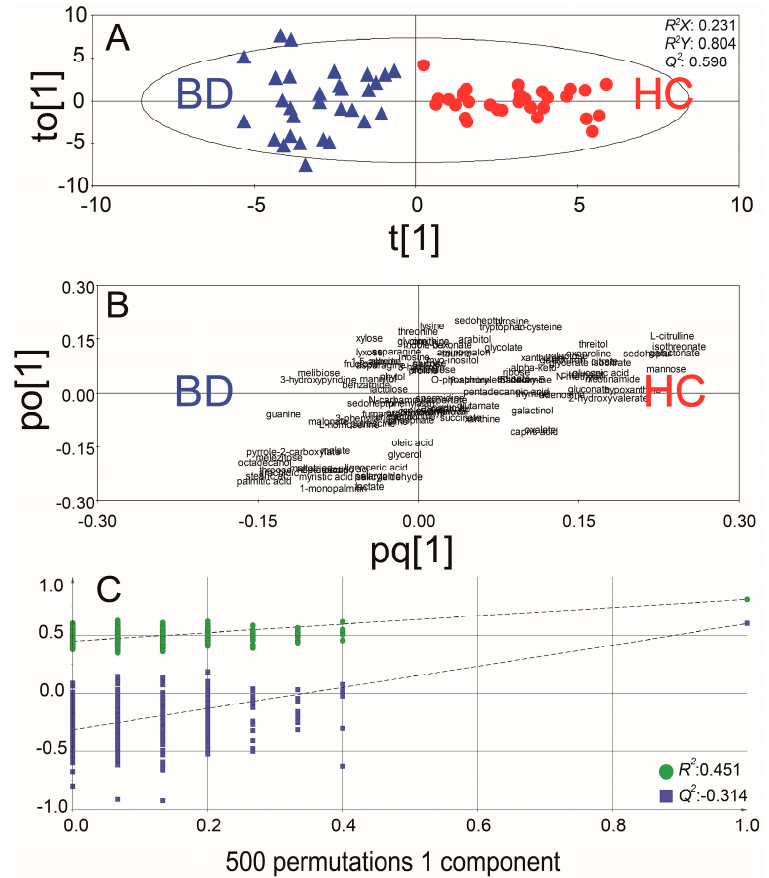
Figure 1. The score plot ( A ), and the loading plot ( B ) of the orthogonal partial least squared-discrimination analysis (OPLS-DA) using 109 identified metabolites of the discovery set. The OPLS-DA score plot showed clear separation between Behcet’s disease ( n = 30) and healthy controls ( n = 30) in the discovery set using 109 identified metabolites ( R 2 X , R 2 Y and Q 2 , at 0.231, 0.804 and 0.598). In the permutation tests, the Y -axis intercepts of R 2 and Q 2 are 0.451 and − 0.314, respectively, indicating that the original model is valid ( C ). The blue triangles and red circles denote Behcet’s disease (BD) and healthy controls (HC), respectively.